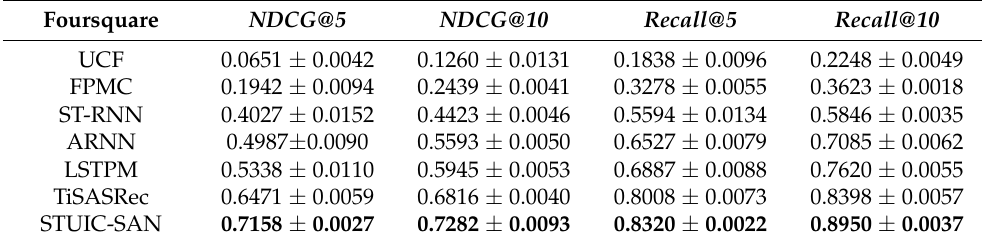
Table 5. Comparison of recommendation performance on Foursquare (mean ±